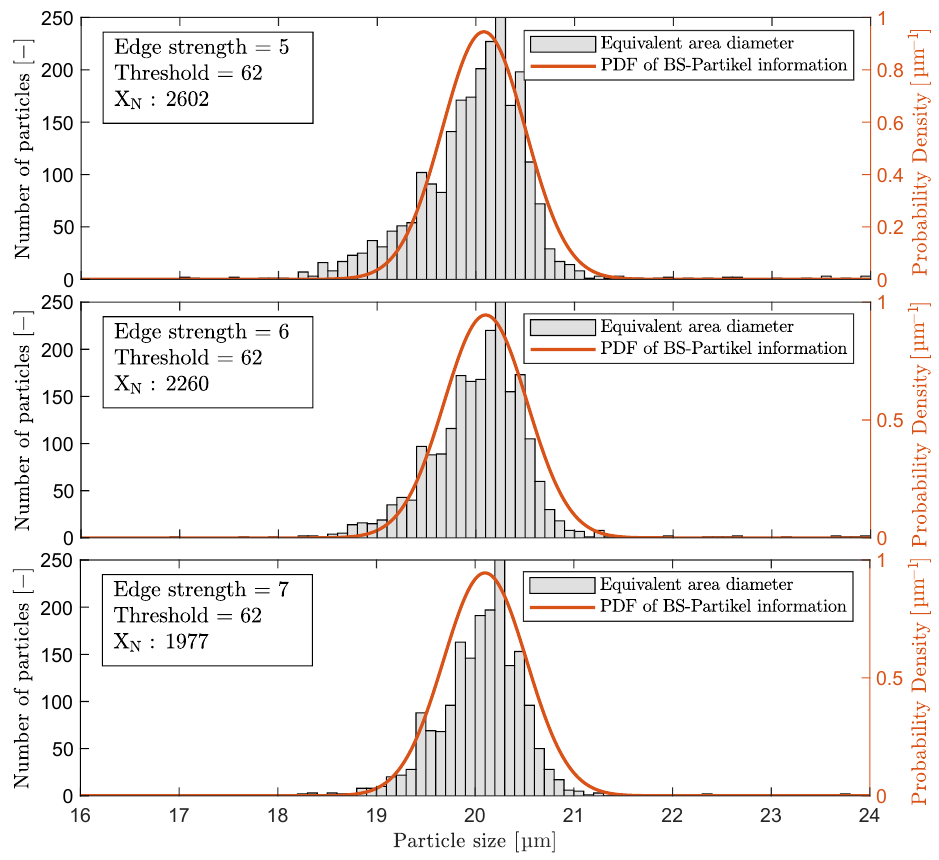
Figure 8. Included particles with a THV = 62 and three different ESVs: 5, 6, and 7, respectively, measured by C 2 .